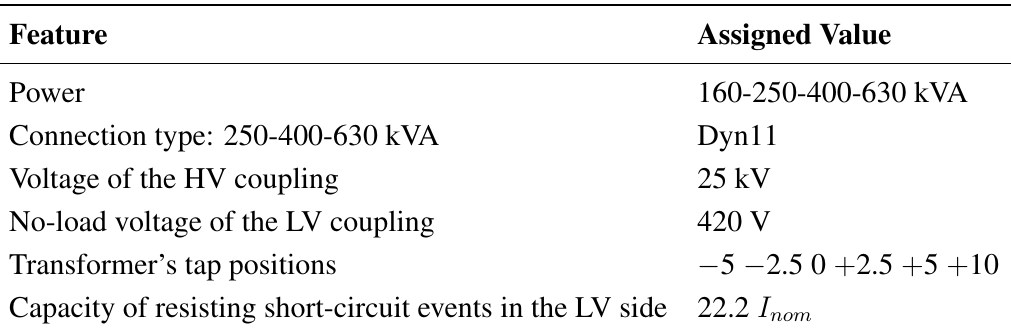
Table 4. Features of the transformers used in the studied grid.